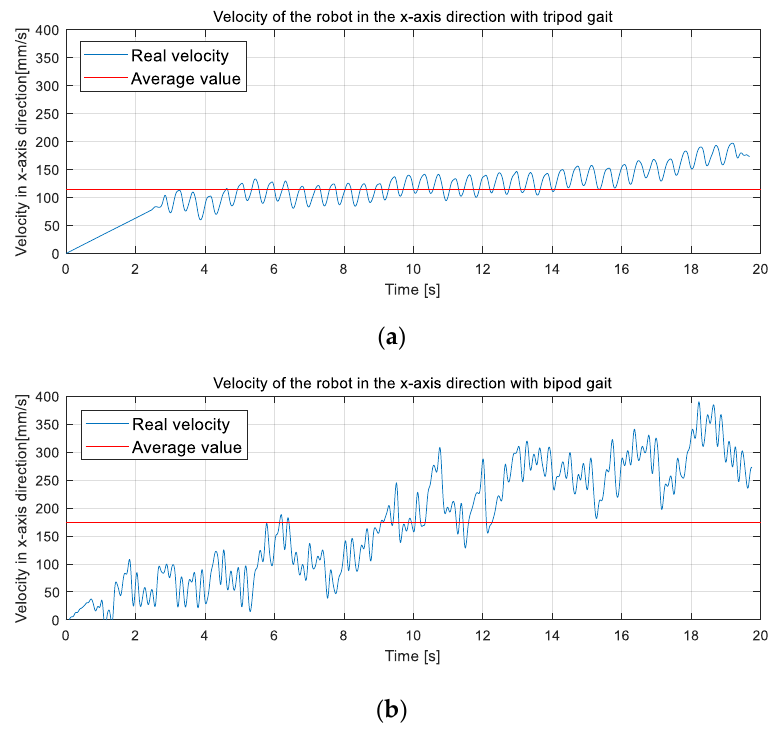
Figure 18. The experimental result of the physical prototype. ( a ) The velocity variation on the X-axis as the robot advanced with a tripod gait. ( b ) The velocity variation on the X-axis as the robot advanced with a bipod gait.